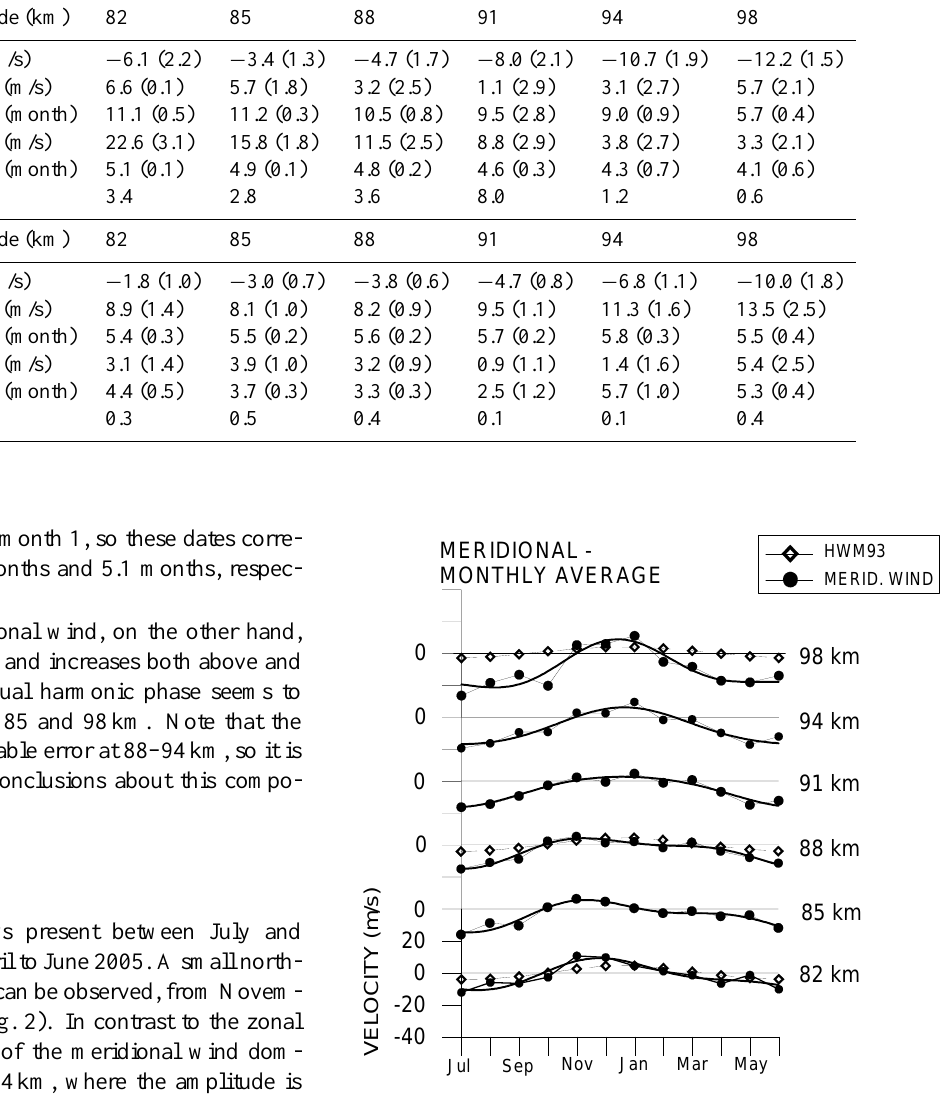
Table 1. Wave parameters of zonal and meridional annual and semiannual winds above Cariri. Phase starts on 1 July 2004, which is taken as day 1 (one).